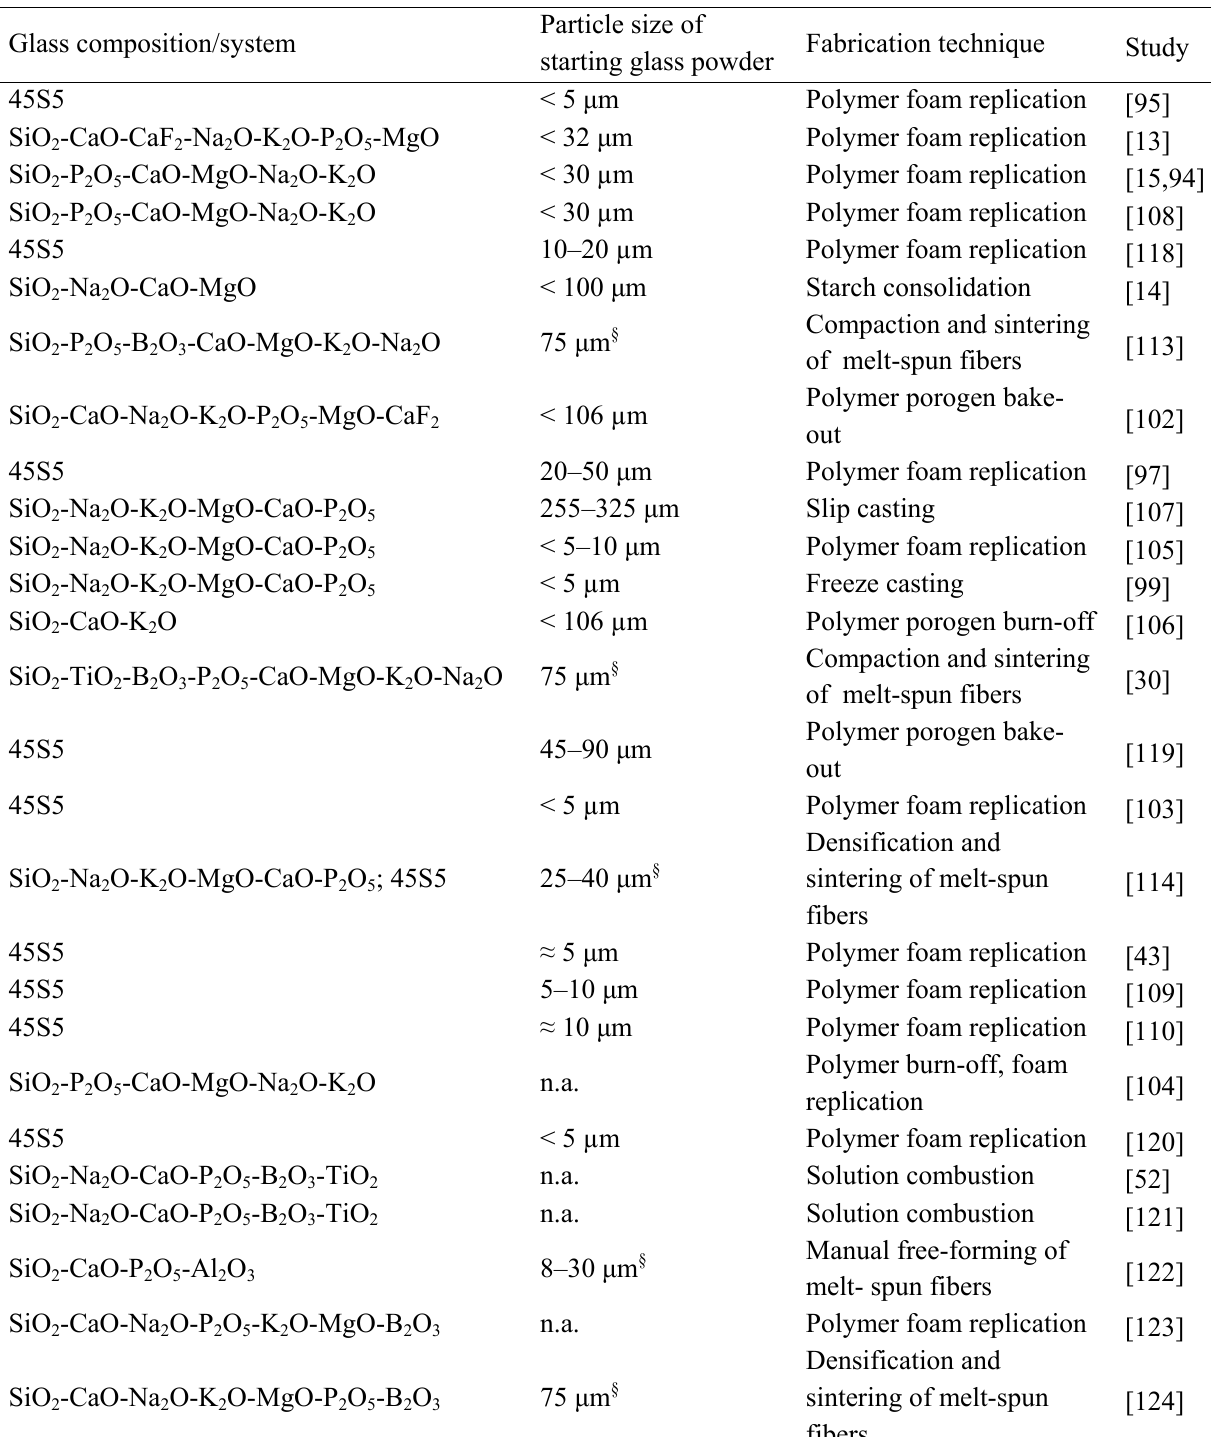
Table 1. Overview on recent studies performed on silicate bioactive glass-ceramic scaffolds. The symbol § denotes fiber